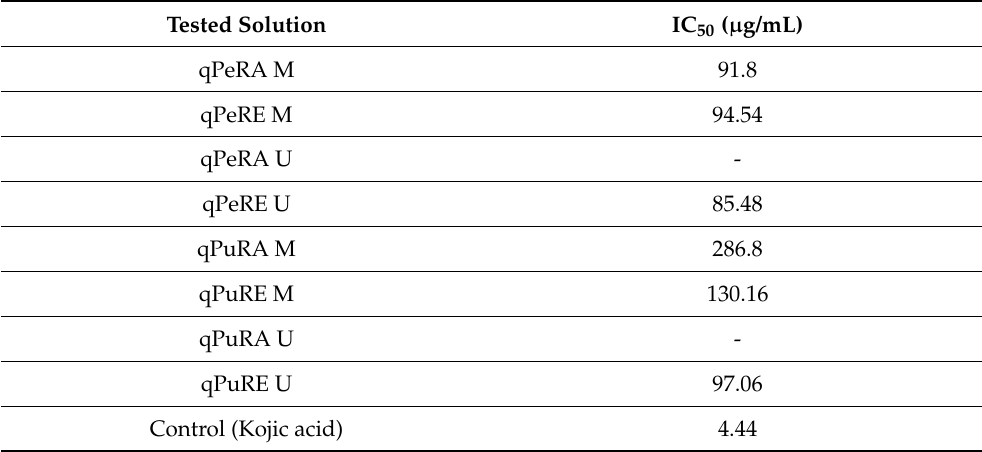
Table 6. IC 50 values for the tested solutions against